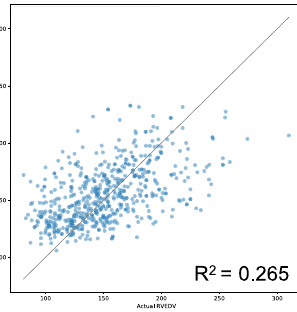
right ventricular end-diastolic volume (RVEDV) on test MRI – ECG